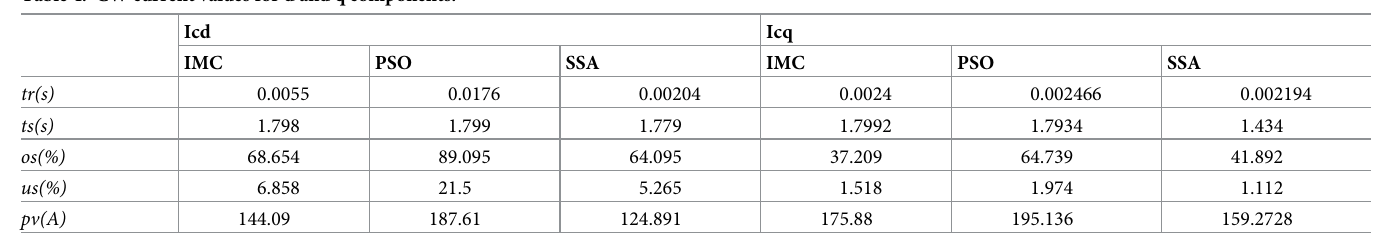
Table 4. CW current values for d and q components.